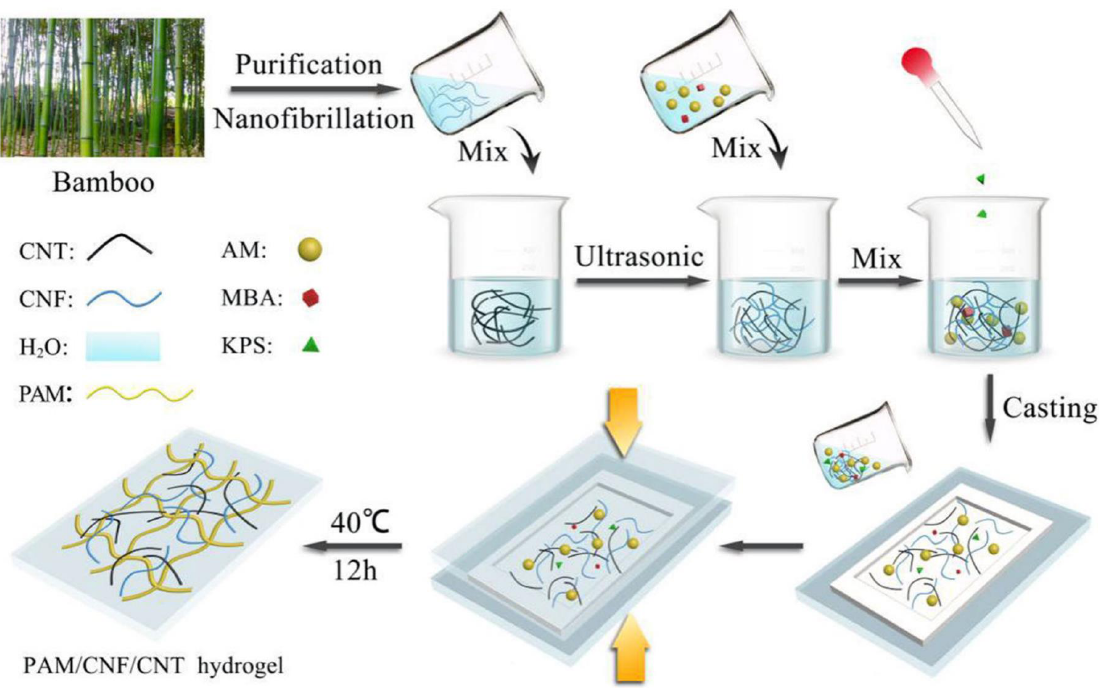
Figure 4. Schematic of the fabrication of PAM/CNF/CNT-n hydrogels [69]. Copyright: Springer Nature.